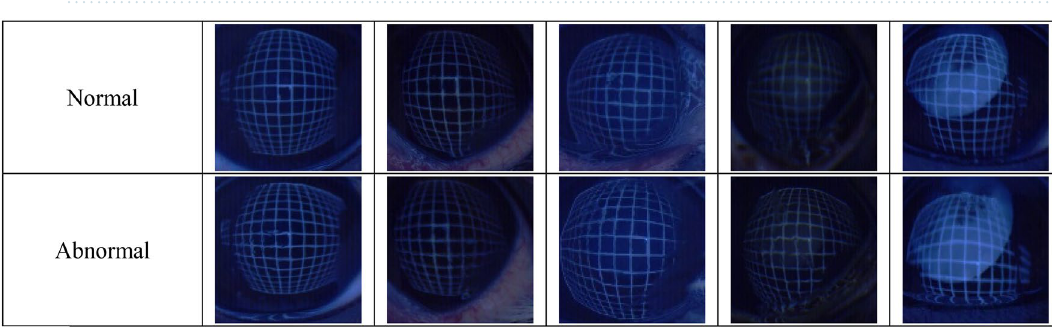
Figure 3. Grid plate design. A window for observation using the slit lamp is located at the center. The plate is placed as close as possible to the slit lamp for maximal visual field from the scope.